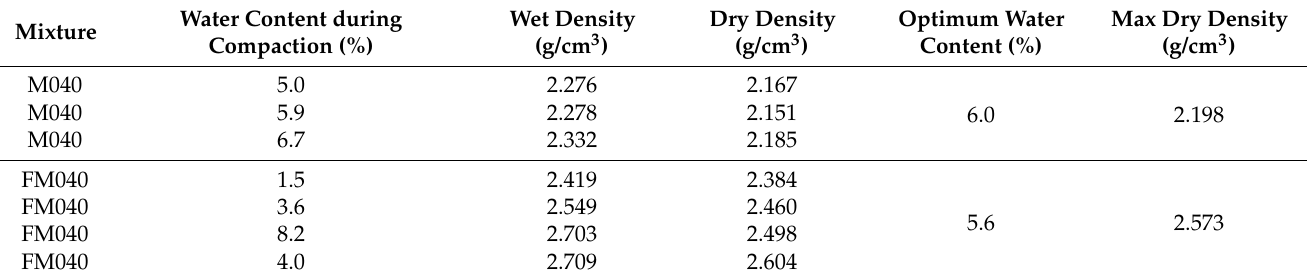
Table 1. UNI EN 13286-2 results for